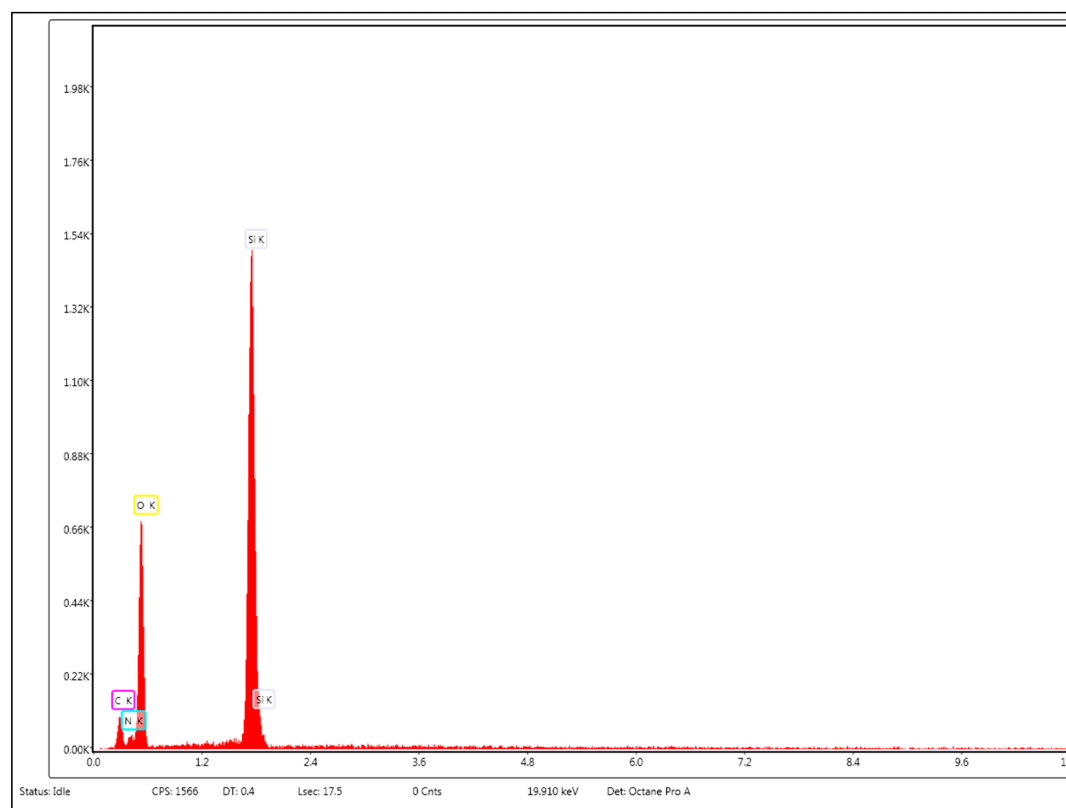
Figure 2. The EDS spectrum for